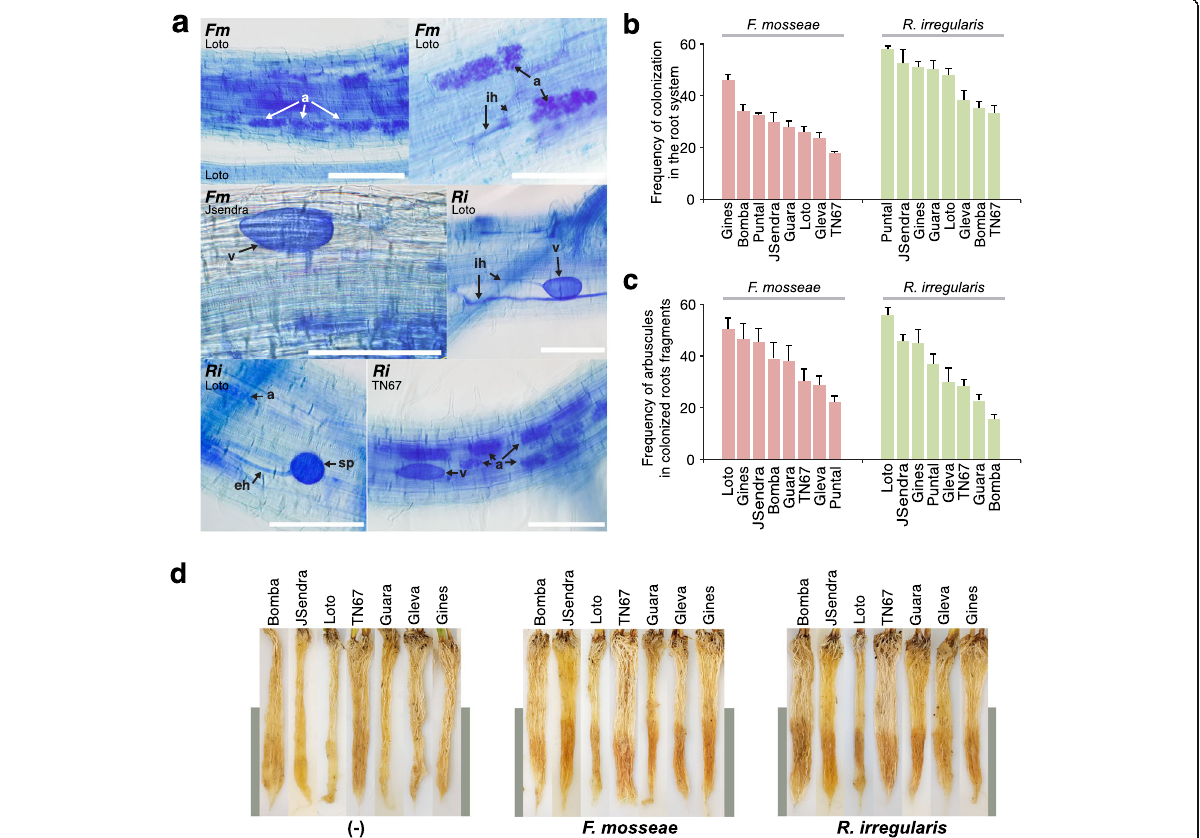
Fig. 3 AM-colonization of temperate rice japonica rice cultivars. Roots from AM-inoculated temperate japonica rice cultivars were collected and analyzed (10 weeks post-inoculation). a Cotton blue staining of rice roots colonized by F. mosseae ( Fm ) or R. irregularis ( Ri ). The typical fungal structures were observed, such as extraradical hyphae (eh), intracellular hyphae (ih), arbuscules (a), vesicles (v), and spores (sp). Scale bar = 100 μ m. b-c Estimation of AM fungal colonization according to the Trouvelot method b F%, frequency of mycorrhiza in the root system, and c a%, arbuscule abundance in mycorrhizal parts of root fragments. d Appearance of roots of rice plants inoculated with AM fungi. Representative pictures are presented. Increased pigmentation is observed in AMF-roots (grey